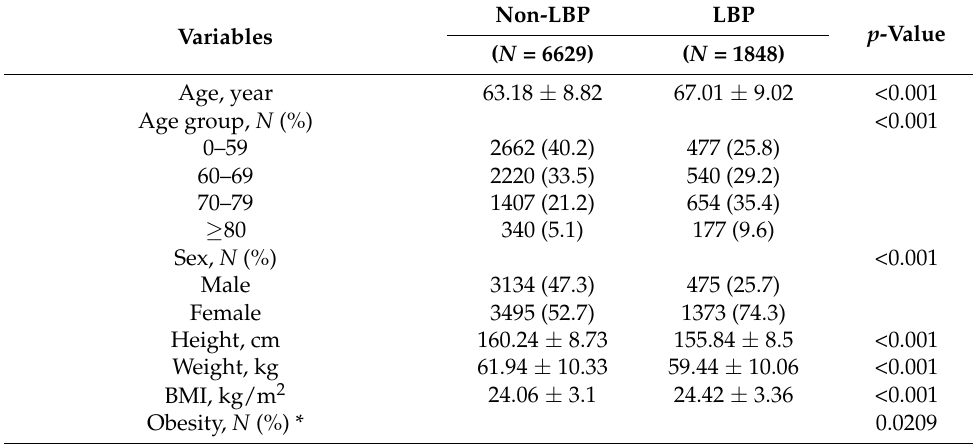
Table 1. General characteristics of the study population.